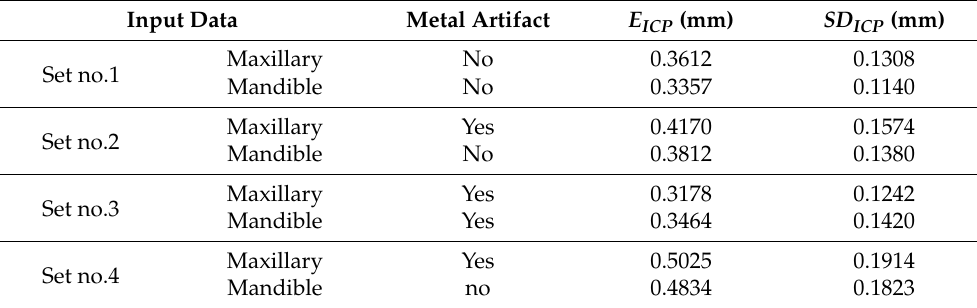
Figure 6. Conventional registration result. (( a ): segmented surface data, ( b ): maxillary, ( c ): mandible) ( 1 ) set no.1 ( 2 ) set no.2 ( 3 ) set no.3 ( 4 ) set no. Table 1. The result of conventional registration.